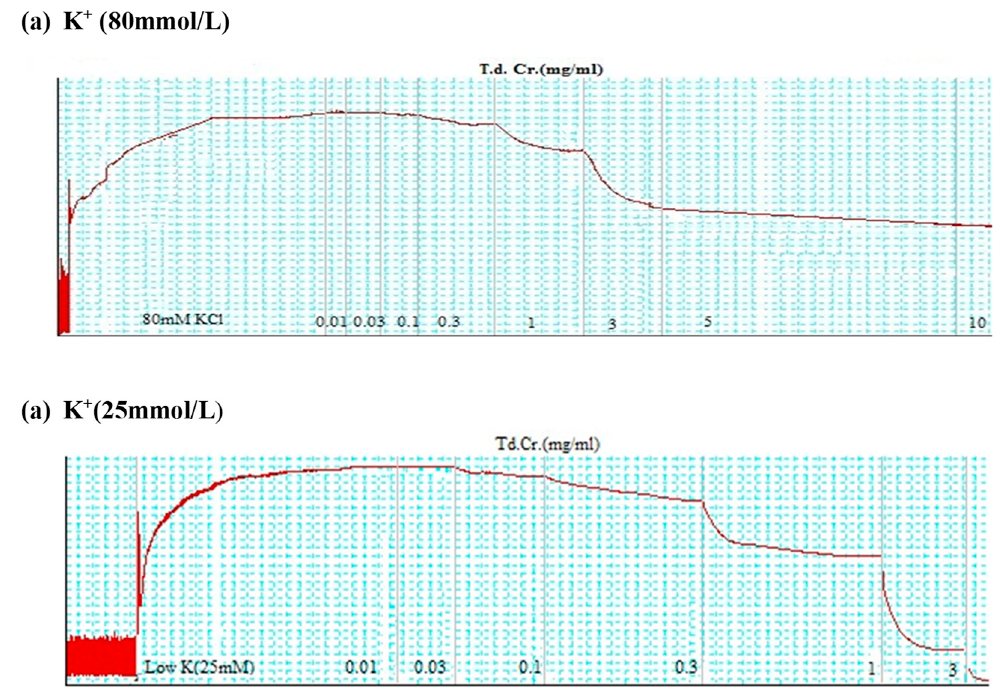
Figure 5. Tracings showing the effect of a methanolic extract of TdCr plant on ( a ) high K + (80 mmol/L) and ( b ) low K + (25 mmol/L)-induced contractions in isolated rabbit jejunum preparations.